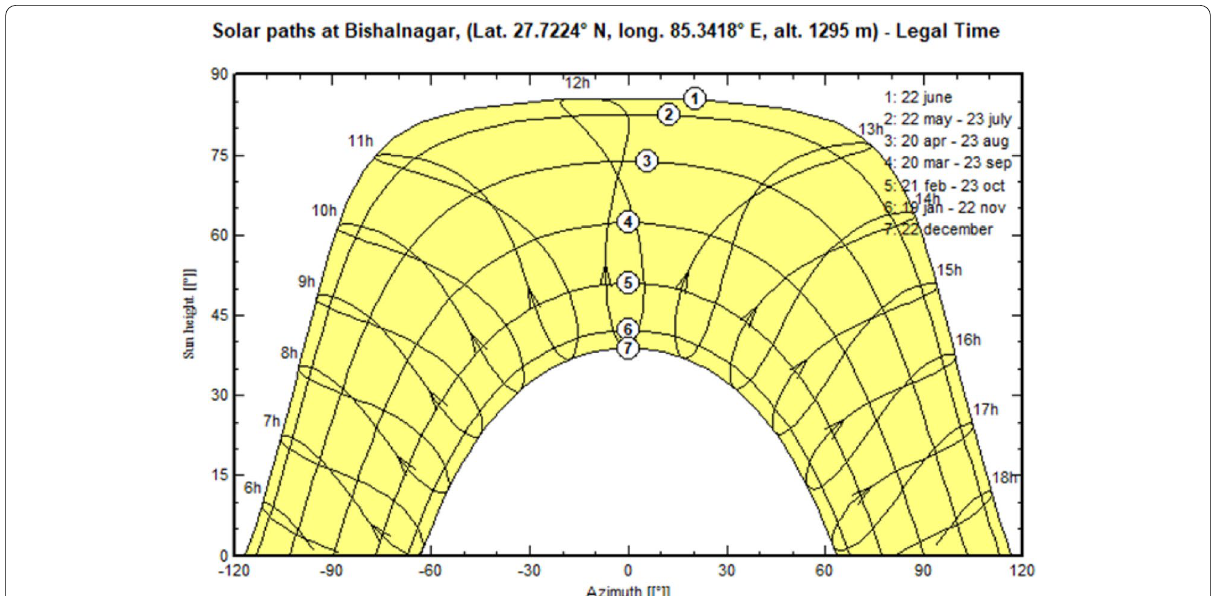
Fig. 4 The solar path of Kathmandu